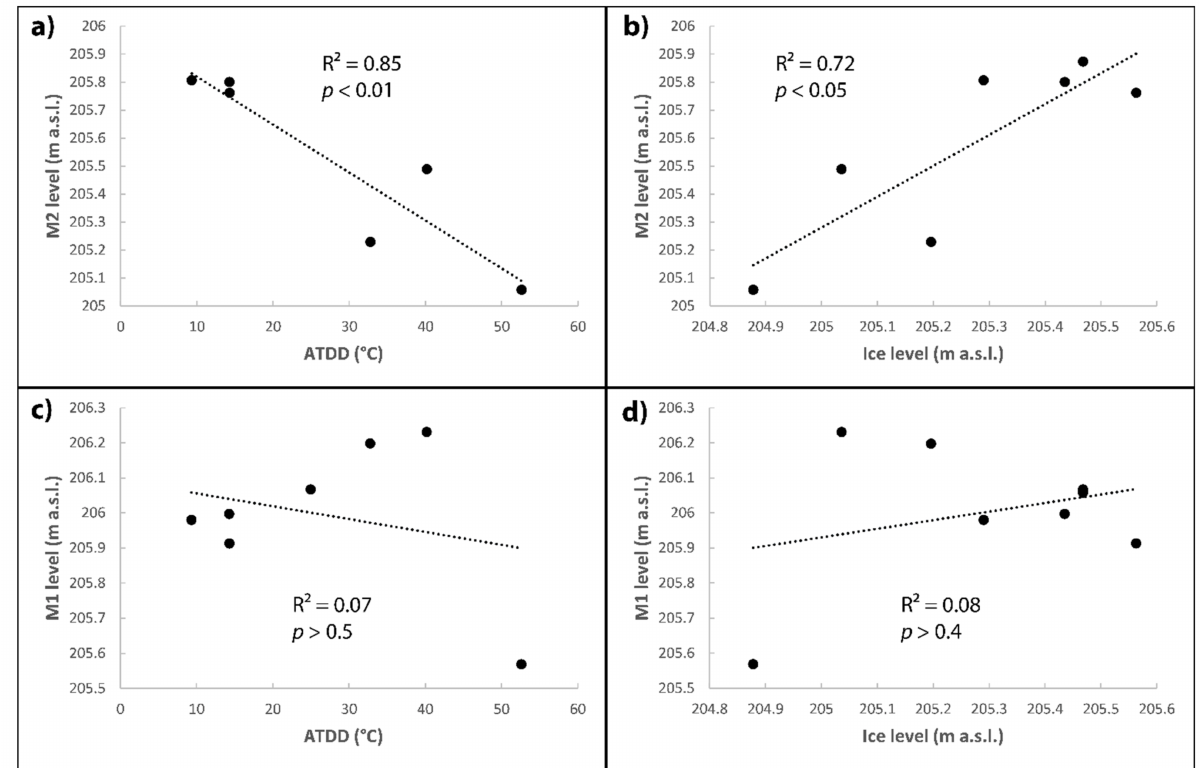
Figure 6. Linear regression between the frost blisters’ elevation change and the ATDD ( a,c ) and the ice level ( b,d ). M2 elevation changes are plotted against the ATDD of the previous year ( a ) and then against the ice level elevation ( b ). Similarly, M1 elevation changes are plotted against the ATDD of the previous year ( c ) and then against the ice level elevation ( d